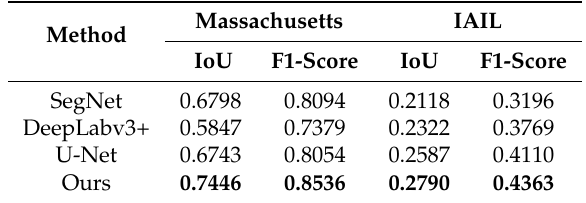
Table 5. Transfer learning results of different